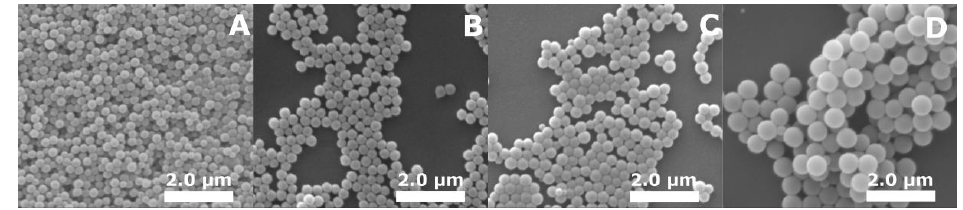
Figure 2. SEM images of hybrid particles obtained at a volume ratio of MPTMS:styrene of ( A ) 1:99, ( B ) 20:80, ( C ) 50:50, and ( D ) 80:20.